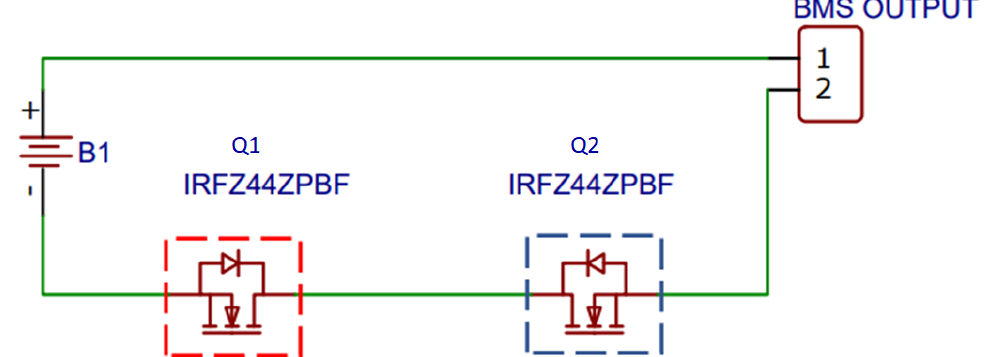
Figure 8. MOSFET in ideal condition.